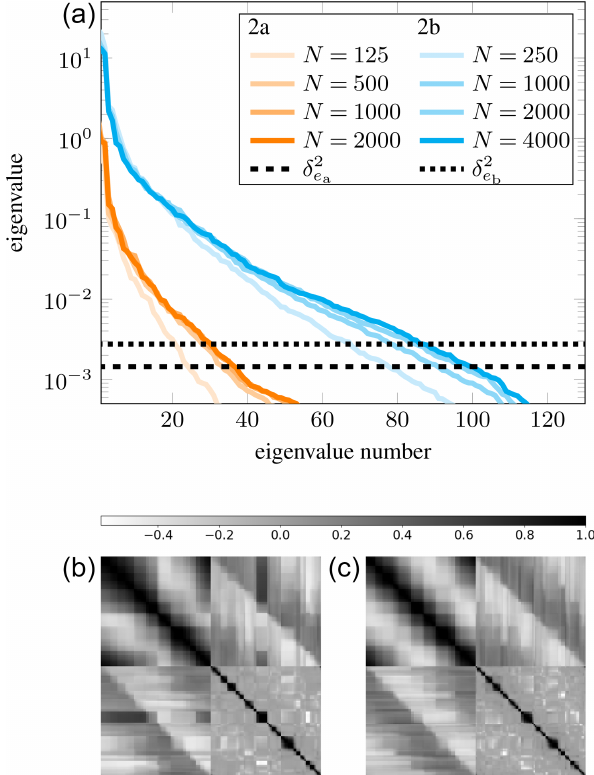
Figure 9. Convergence and (Pearson’s) correlation matrix of the approximation errors for Example 2. (a) Spectrum of (cid:48) ε for various sample sizes, N , for Example 2a (orange) and Example 2b (cyan), along with the noise variance for Example 2a, δ 2 e , and Example 2b, a δ 2 e . (b, c) (Pearson’s) correlation matrix of the approximation errors b for Example 2a (b) and Example 2b (c)